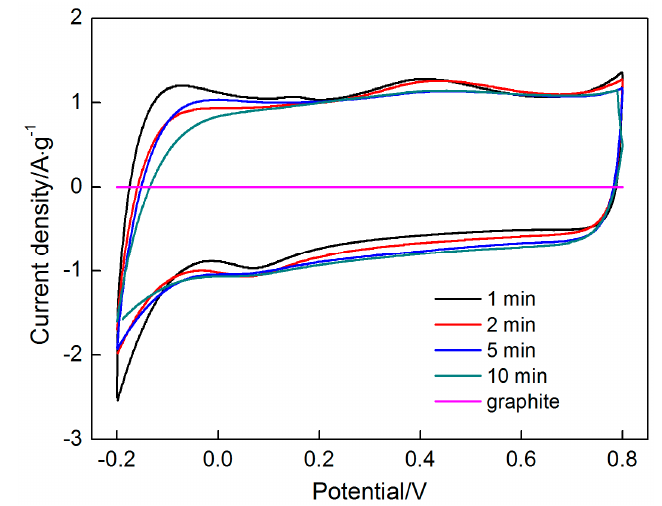
Figure 15. Cyclic voltammograms of graphite and the MnO 2 -based electrode at different deposition time from 1 min to 10 min.